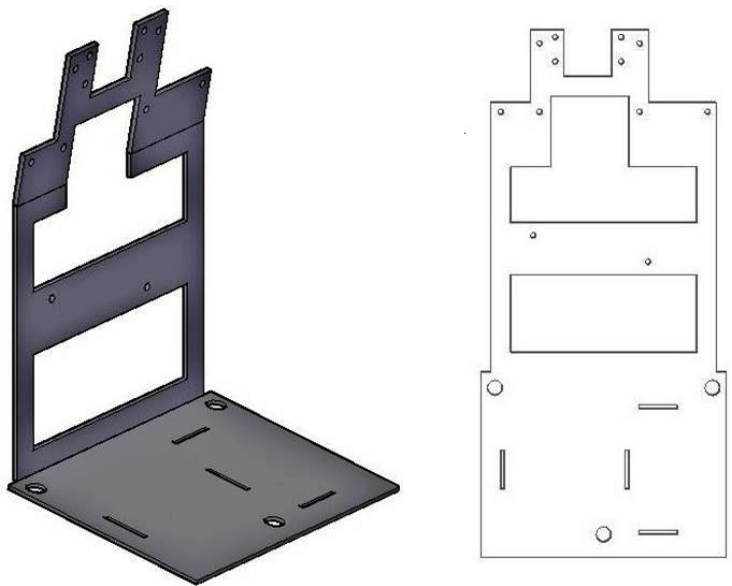
Figure 6. ( Left ) The frame plate partially folded; ( Right ) the drawing of the frame